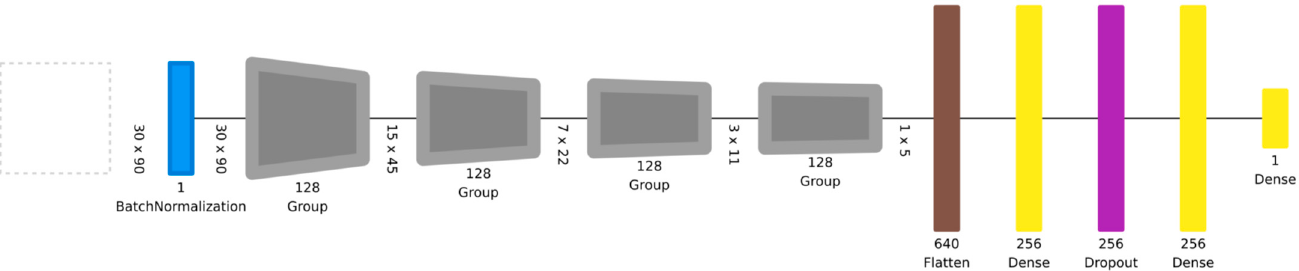
Figure 1. Deep Learning